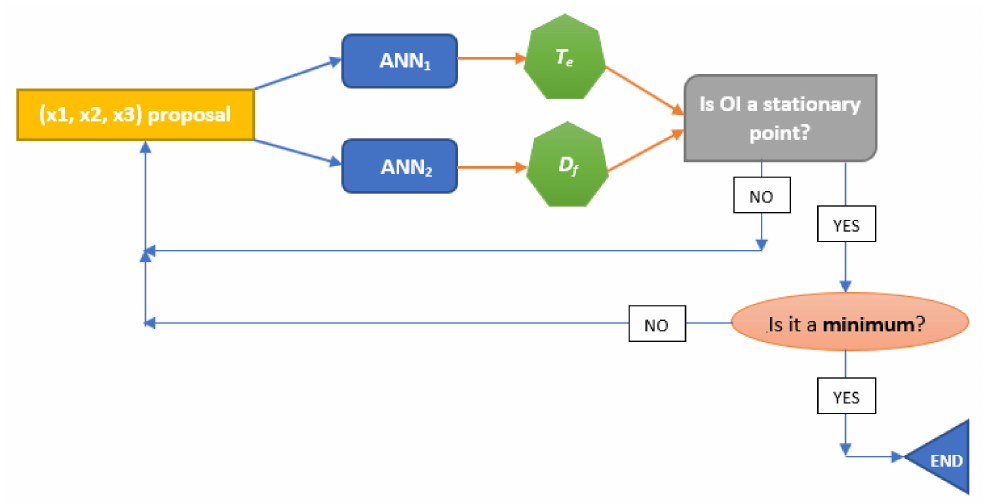
Figure 2. Optimisation scheme of the following iterations for artificial neural network (ANN) method. (OI: optimization